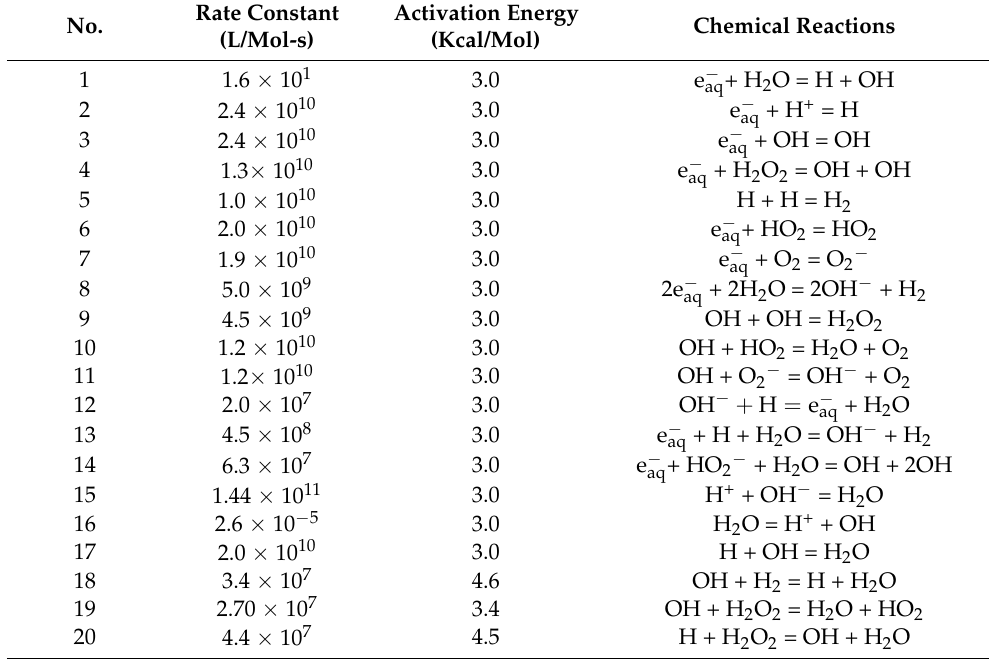
Table 5. Radiolysis model used by Macdonald et al. [216–244] to model the primary coolant chemistry of BWRs, with the rate constant of Reaction (30) being used as the “calibrating” parameter. All but Reaction (30) and its kinetic data come from Burns and Moore